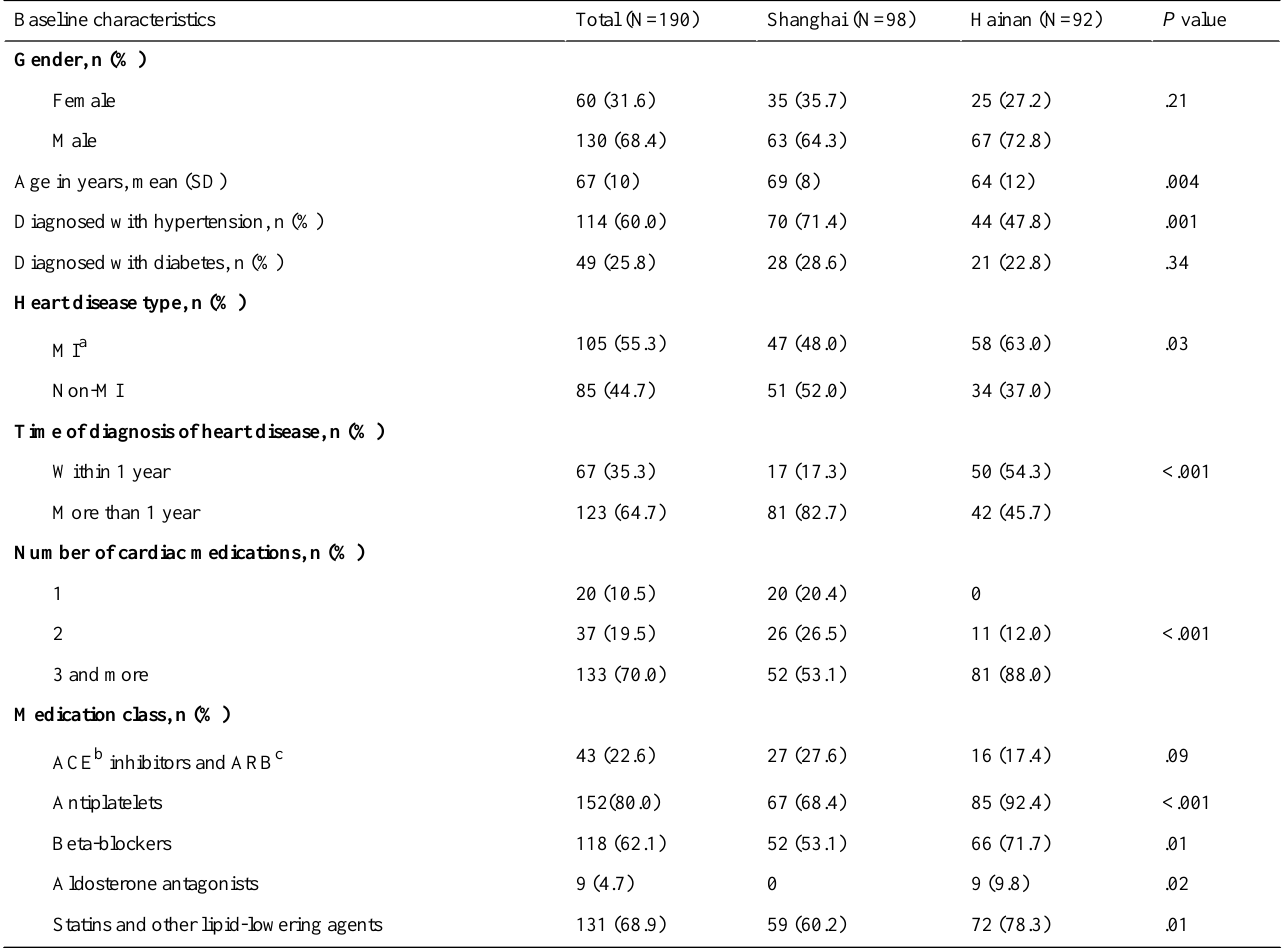
Table 1. Demographic, health status, and medicine use of patients at